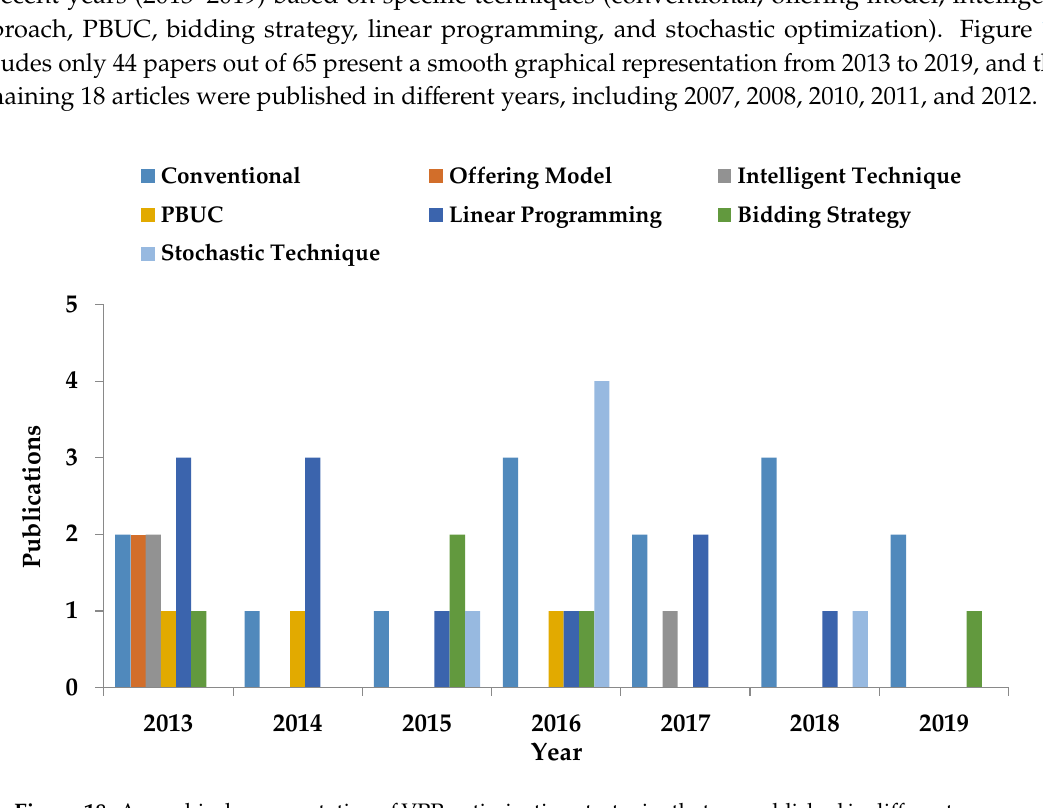
Figure18. AgraphicalrepresentationofVPPoptimizationstrategiesthatarepublishedindi ff